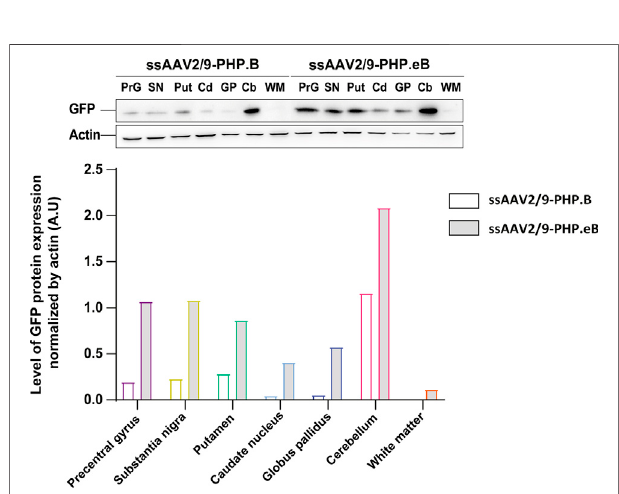
FIGURE 3 | Stronger widespread brain EGFP distribution after intrathecal injection of AAV-PHP. eB compared to variants AAV-PHP.B. Representative images and quanti fi cation of EGFP expression analyzed across brain lysates of AAV-injected monkeys.